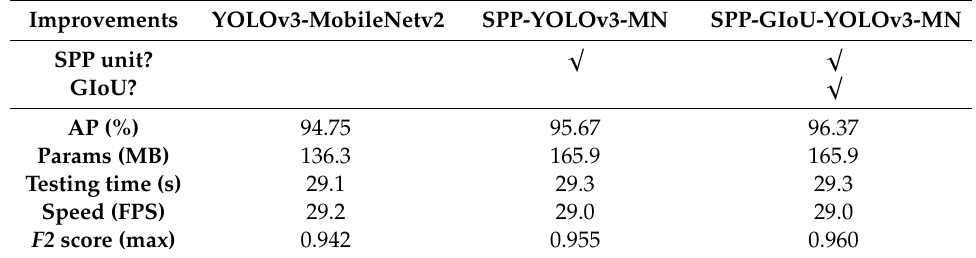
Table 7. Model comparison between the enhanced YOLOv3 models and the original model.